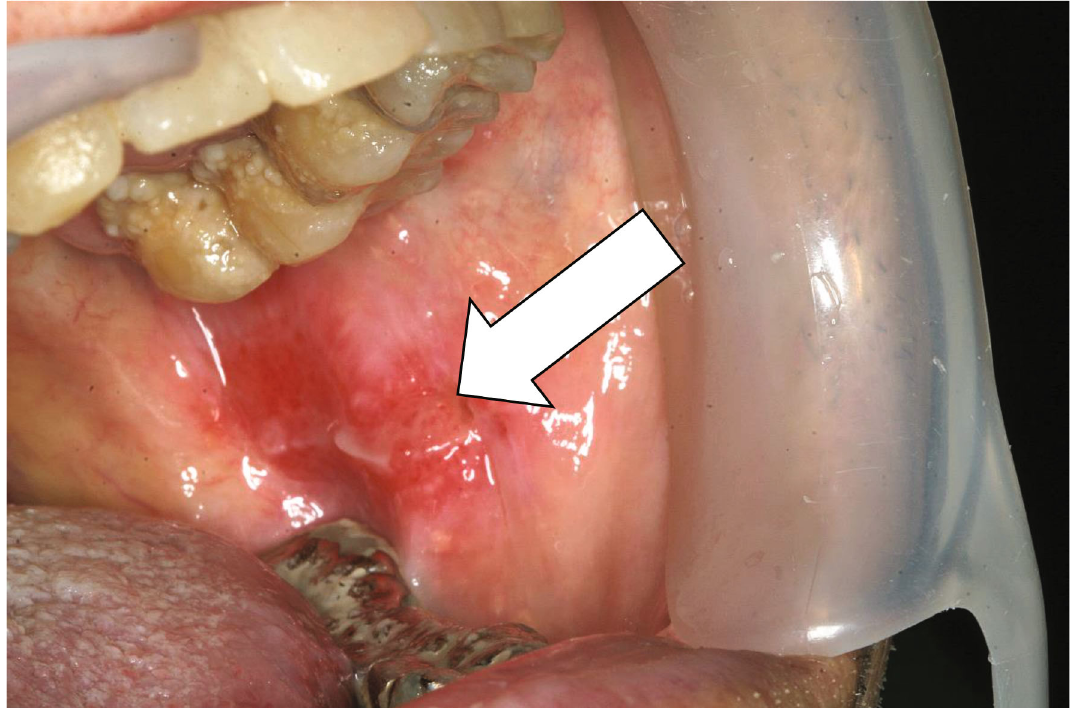
Figure 4: Oral fi ndings on day 9 after initiation of ganciclovir therapy. A persistent ulcer on the left buccal mucosa is visible, with reduced signs of in fl ammation. Open arrow: cytomegalovirus-associated